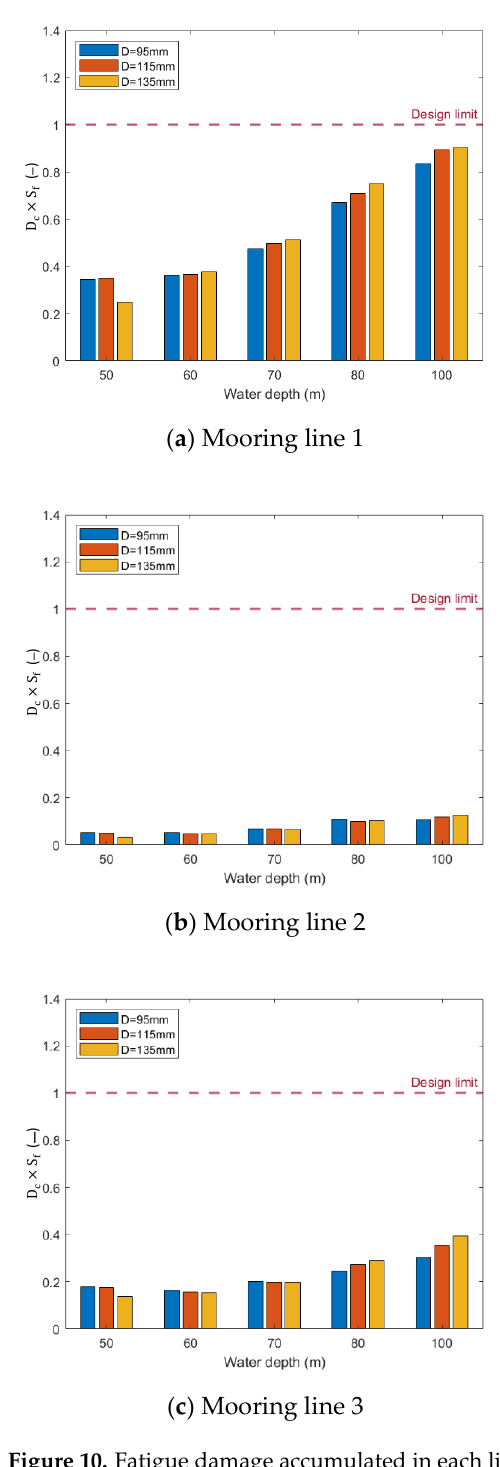
Figure 10. Fatigue damage accumulated in each line for the different water depths. The term in front of the multiplication represents the possibility of the mooring breaking under ULS load case and the term in parentheses indicates the possibility of the mooring failure under the FLS load case. Therefore, the smaller the tension-fatigue value is, the better the performance and more reliable the mooring design can be. Figure 11 presents the performance index value of each mooring line calculated through the previous analysis